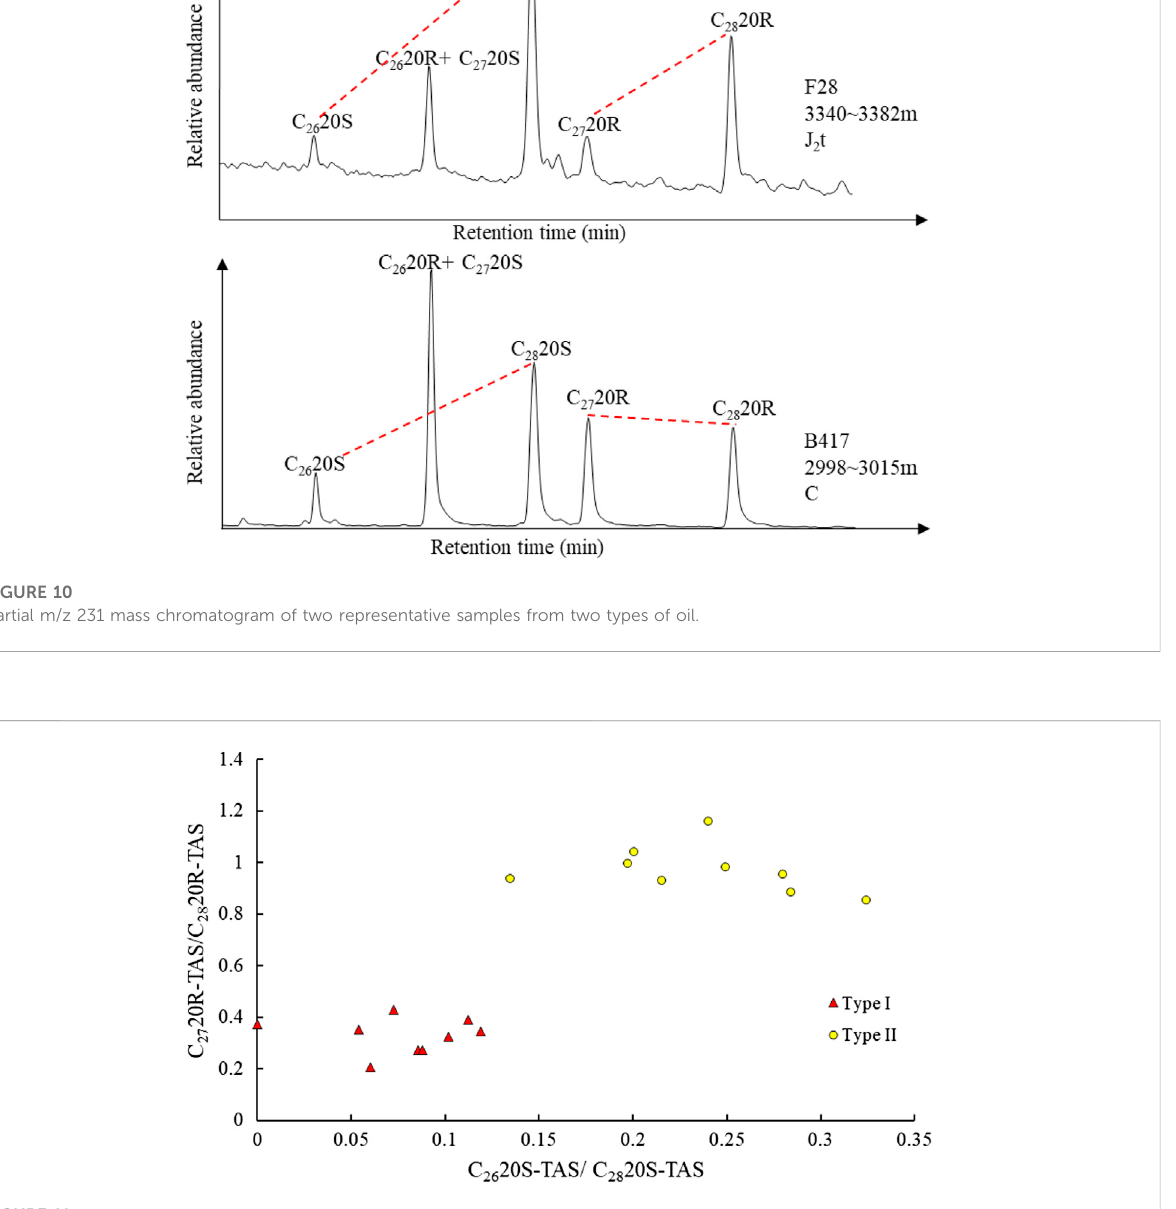
FIGURE 11 The cross plot of C 26 20S-TAS/C 28 20S-TAS versus C 27 20R-TAS/C 28 20R-TAS in crude oil from the East Fukang